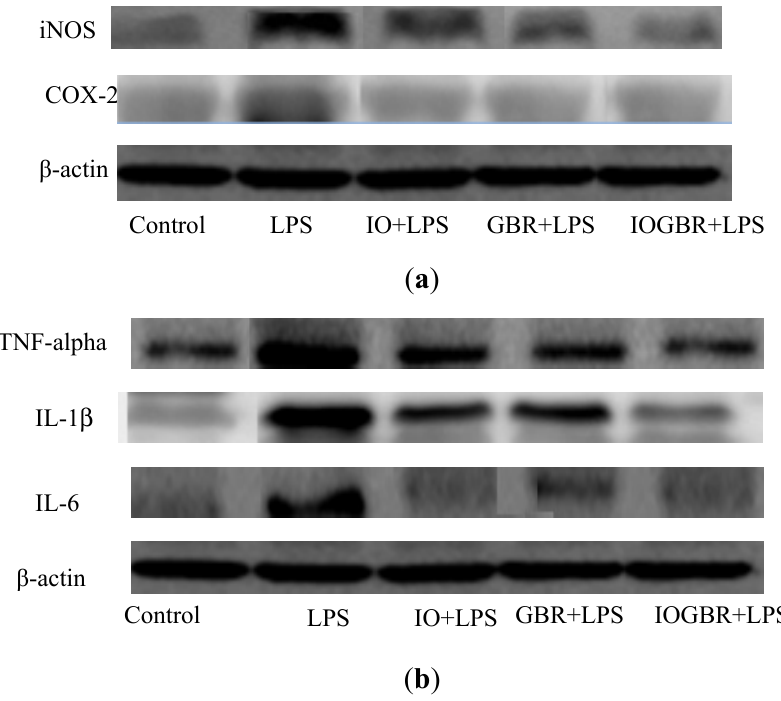
Figure 4. The effect of the extracts from Inonotus obliquus (IO), germinated brown rice (GBR) and Inonotus obliquus grown on germinated brown rice (IOGBR) on protein